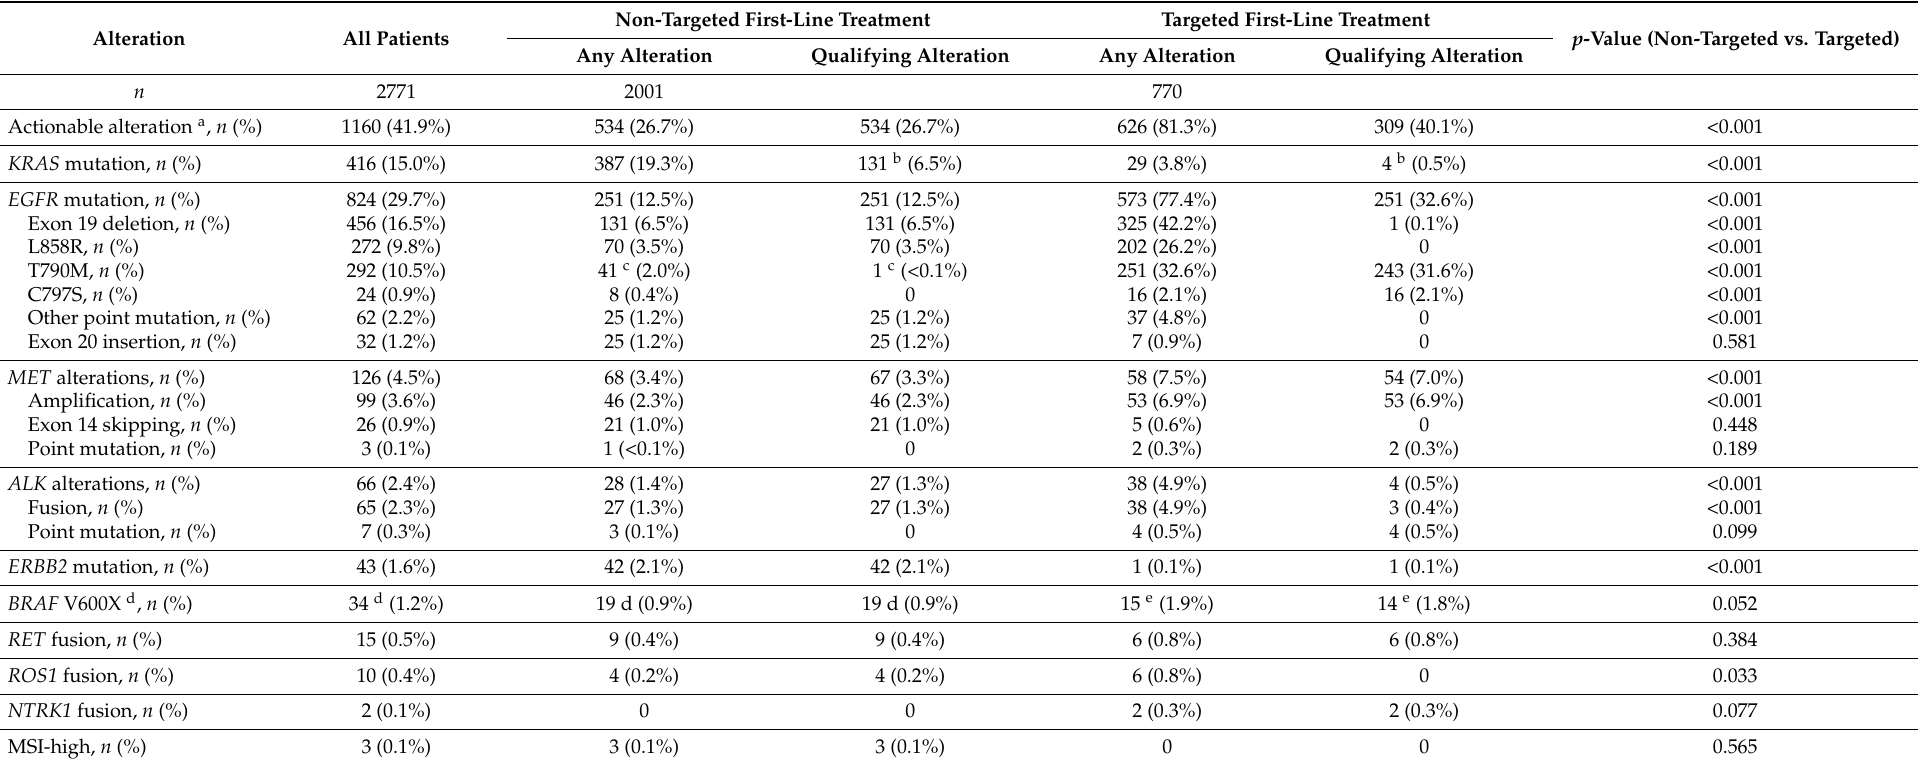
Table 3. Molecular alterations identified using the Guardant360 assay in patients with detectable